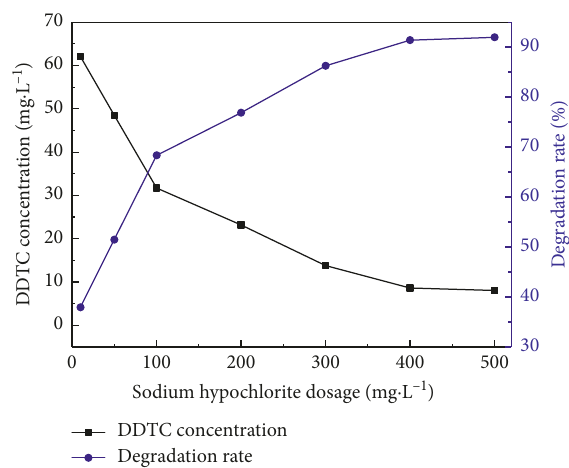
Figure 4: Influence of the stewing time on the degradation of